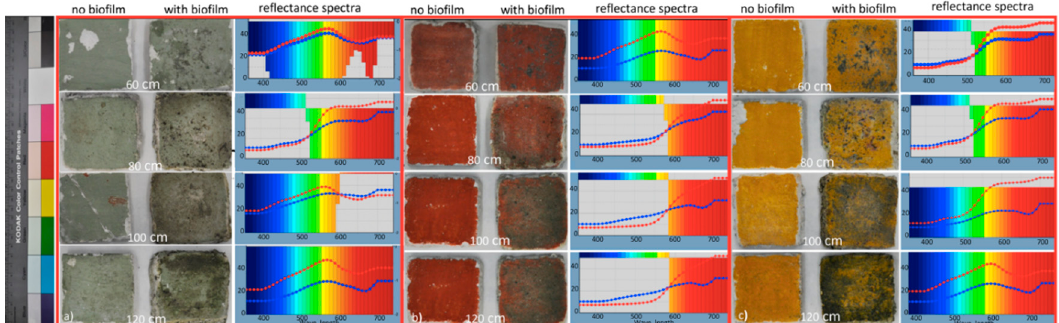
Figure 3. On the left side, the Kodak reference color chart is shown. In ( a ), the pictures of green color samples with and without biofilms, exposed to a different distance from UV ‐ C irradiation are displayed. For each sample, the reflectance spectra are also reported. The red line refers to the reflectance spectrum of untreated samples exposed to UV ‐ C radiation, while the blue line refers to samples with biofilm and subjected to UV ‐ C treatment. In ( b , c ), the pictures of red and yellow samples, together with their reflectance spectra, are, respectively, shown.